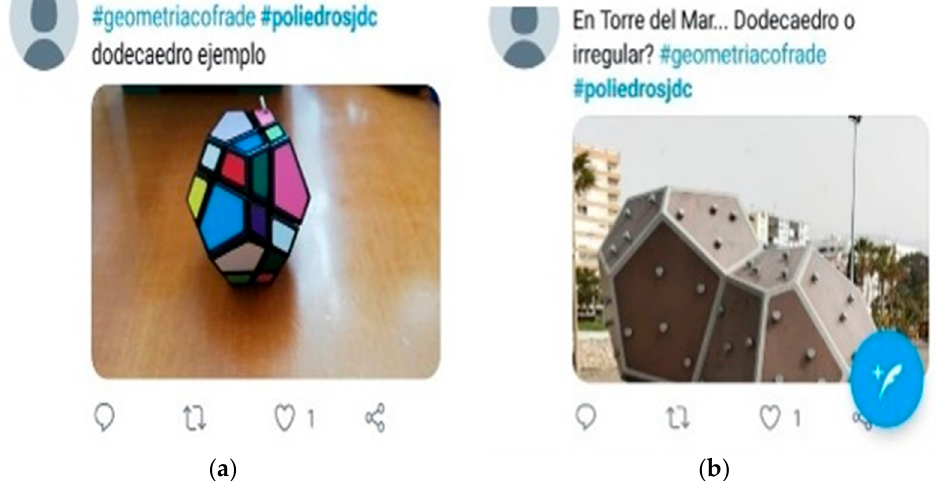
Figure 18. ( a ) Tweet with a dodecahedron key ring; ( b ) Tweet with dodecahedron shape play-